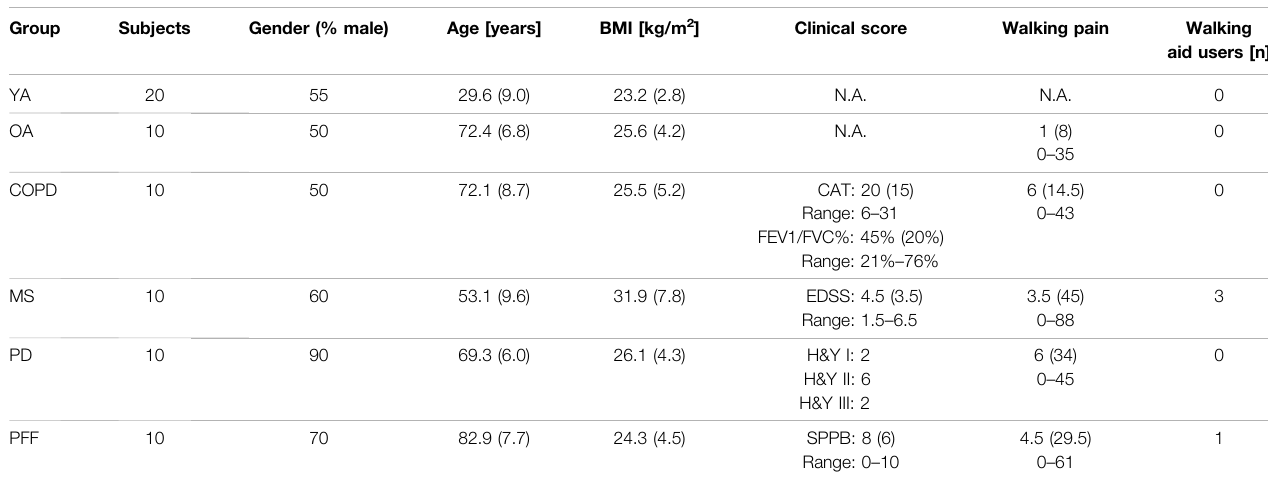
TABLE 2 | Demographic and clinical characteristics of the study